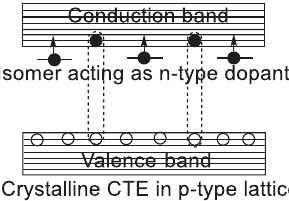
Fig. 3 Schematic diagram to show the formation of electron – hole pairs in crystalline lattice through Coulomb capture between minority electrons and majority holes toward generating crystalline charge-transfer excitons (CTE) in p-type organic crystal under n-type doping. Isomer molecules are functioning as n-type dopants to donate electrons into p-type organic crystal.